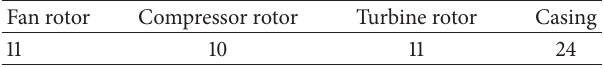
Table 1: Unit number of rotors and